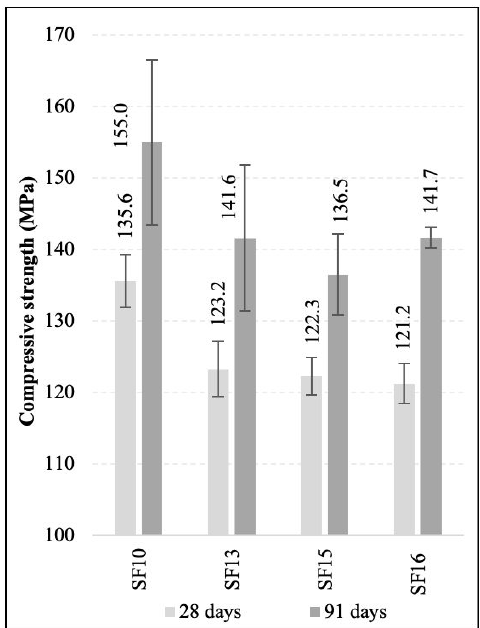
Figure 10. Compressive strength of the ternary pastes with PC, SP and